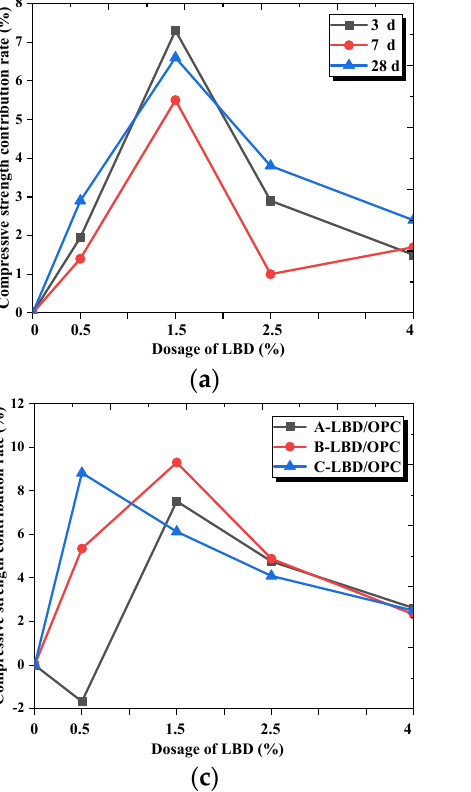
Figure 6. Compressive strength contribution rate of LBD to OPC materials: ( a ) Influence of B-LBD dosages; ( b ) Influence of C-LBD dosages; ( c ) Influence of LBD fineness levels (curing for 28